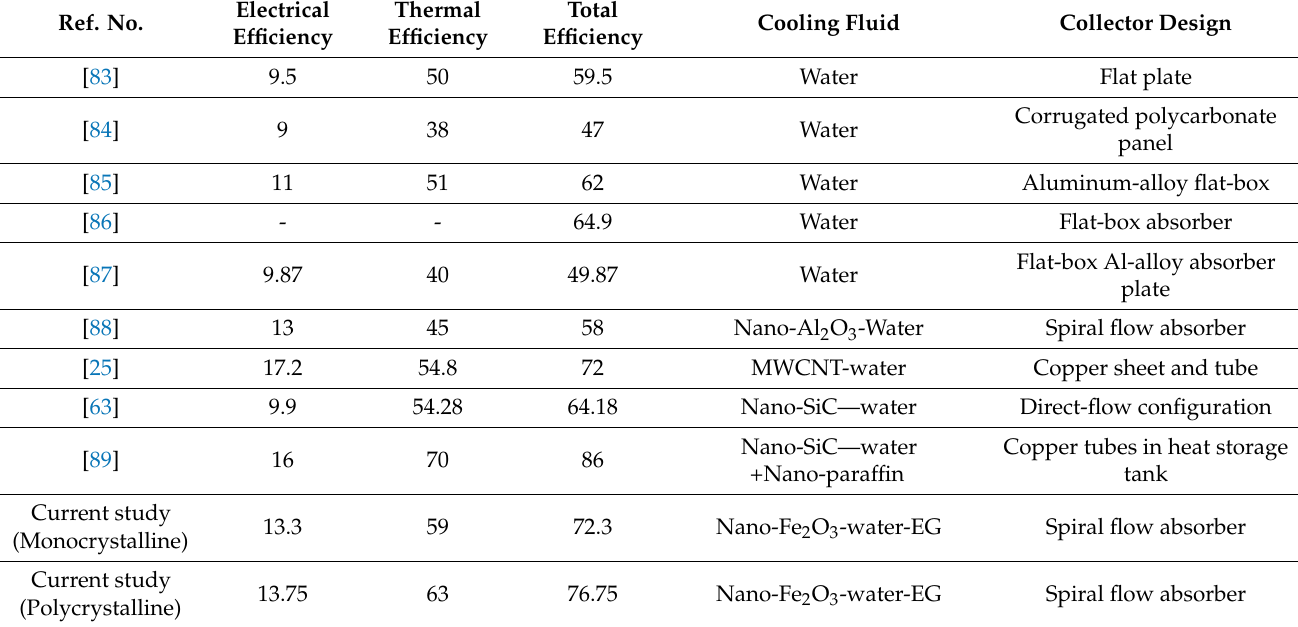
Table 7. A comparison of energy analysis of recent study and others from